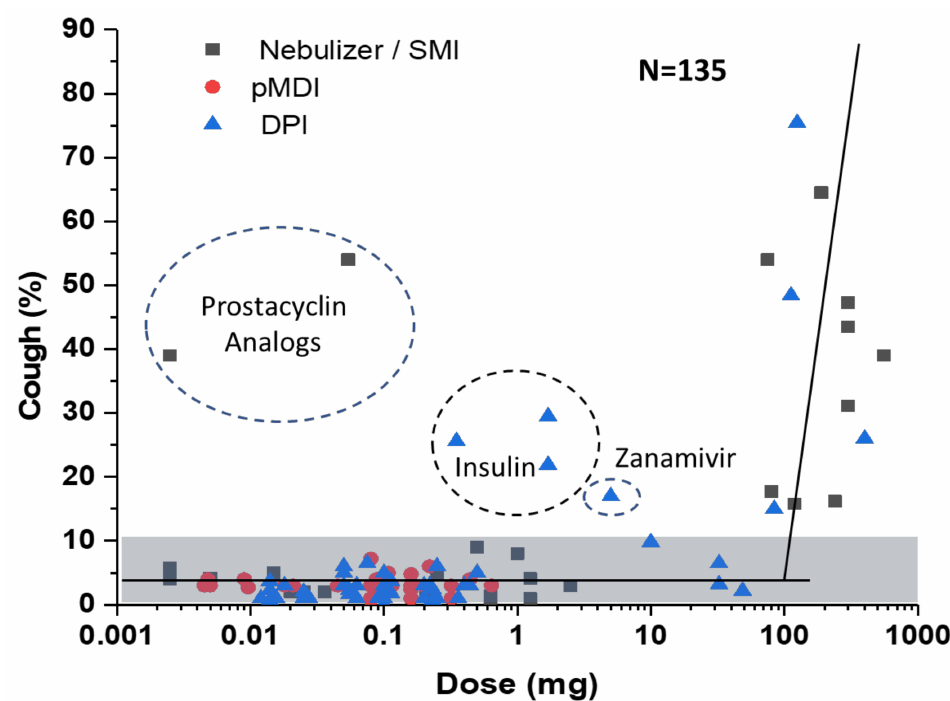
Figure 7. Impact of increases in nominal dose on the incidence of post-inhalation cough. The results are also presented with respect to the various delivery systems (square: nebulizers and soft mist inhalers (SMIs); circle: pressurized metered dose inhalers (pMDIs); triangle: dry powder inhalers (DPIs)). Reproduced with permission from [12]. Copyright Elsevier,